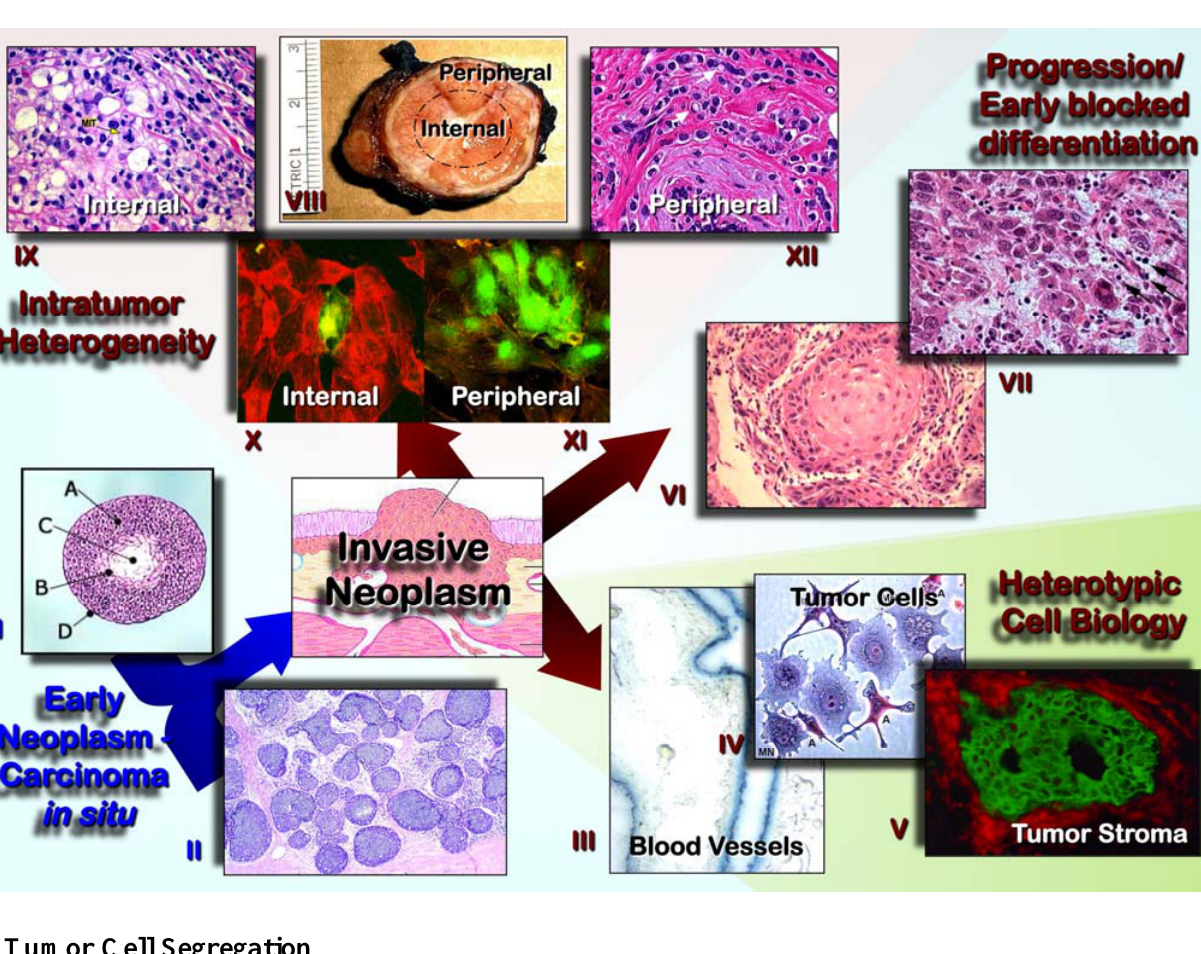
Figure 1. Morphological evaluation of neoplasms and development of oncology. Histopathology, as the gold standard of tumor diagnosis, has set up the bases and criteria for the concept of early neoplasms (I showing encapsulated tumor of epithelial cells, A, with central area of edema, C, and a transitional zone, B; D represent the tumor capsule) and carcinomas in situ (II shows a breast lobular carcinoma in situ ). Histopathology is contributing to a better understanding of the heterotypic cell biology (III to V reveal tumor cells, blood vessels, inflammatory/immune cells, and stroma; tumor cells and stroma are highlighted by direct immunofluorescence for E-cadherin, green, and integrin, red), the biologic progression/dedifferentiation that has been linked to hypoxic conditions and has been frequently reported in recurrent tumors (VI and VII shows well and poorly differentiated squamous cell carcinoma, respectively, in a recurrent neoplasm), and the intratumor heterogeneity and segregation of tumor cells in predominantly expansile internal compartments IX and X) and predominantly invasive peripheral compartments (XI and XII). The expression of hypoxia up-regulated genes is predominantly observed in the internal compartments (green immunofluorescence for HIF-1  in the